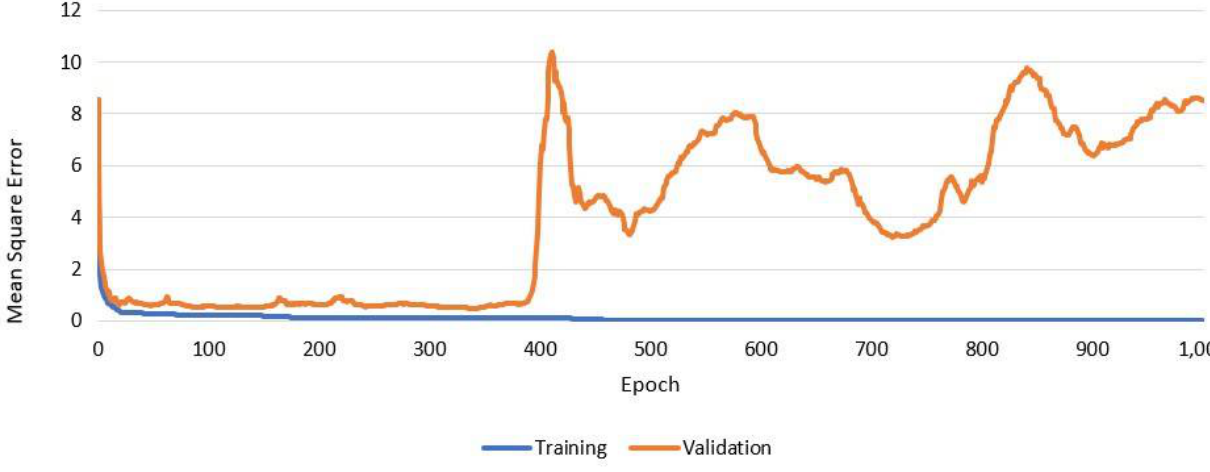
Figure 4. The training set and validation set error during the training process for an ANN with 3 hidden layers, 3 neurons per hidden layer and employs the tanh activation function.